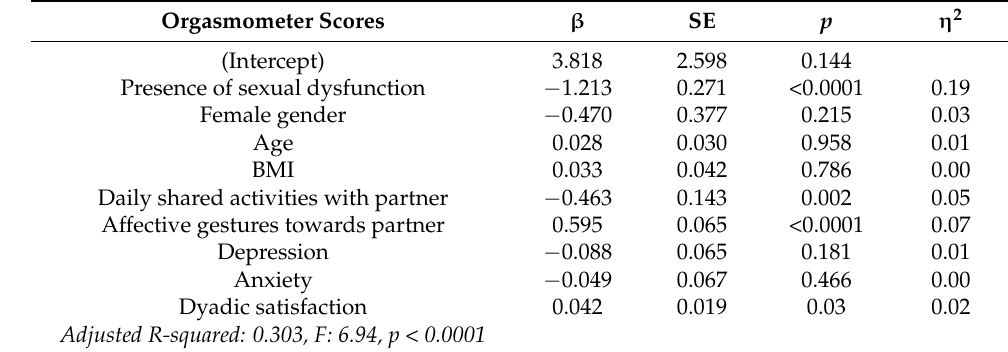
Table 3. Results of the linear regression for the Orgasmometer scores in the study sample. Orgasmometer